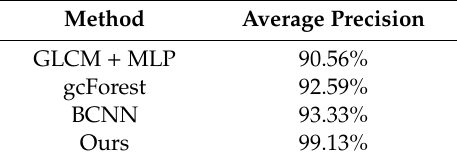
Table 4. Comparison of results on fluorescent magnetic powder surface defect dataset.